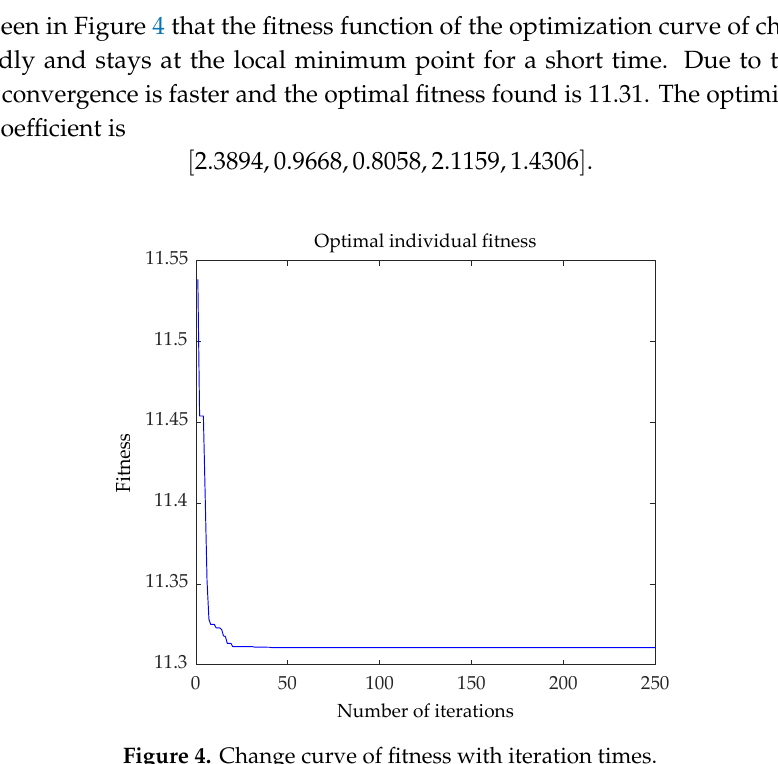
Figure 4. Change curve of fitness with iteration times.